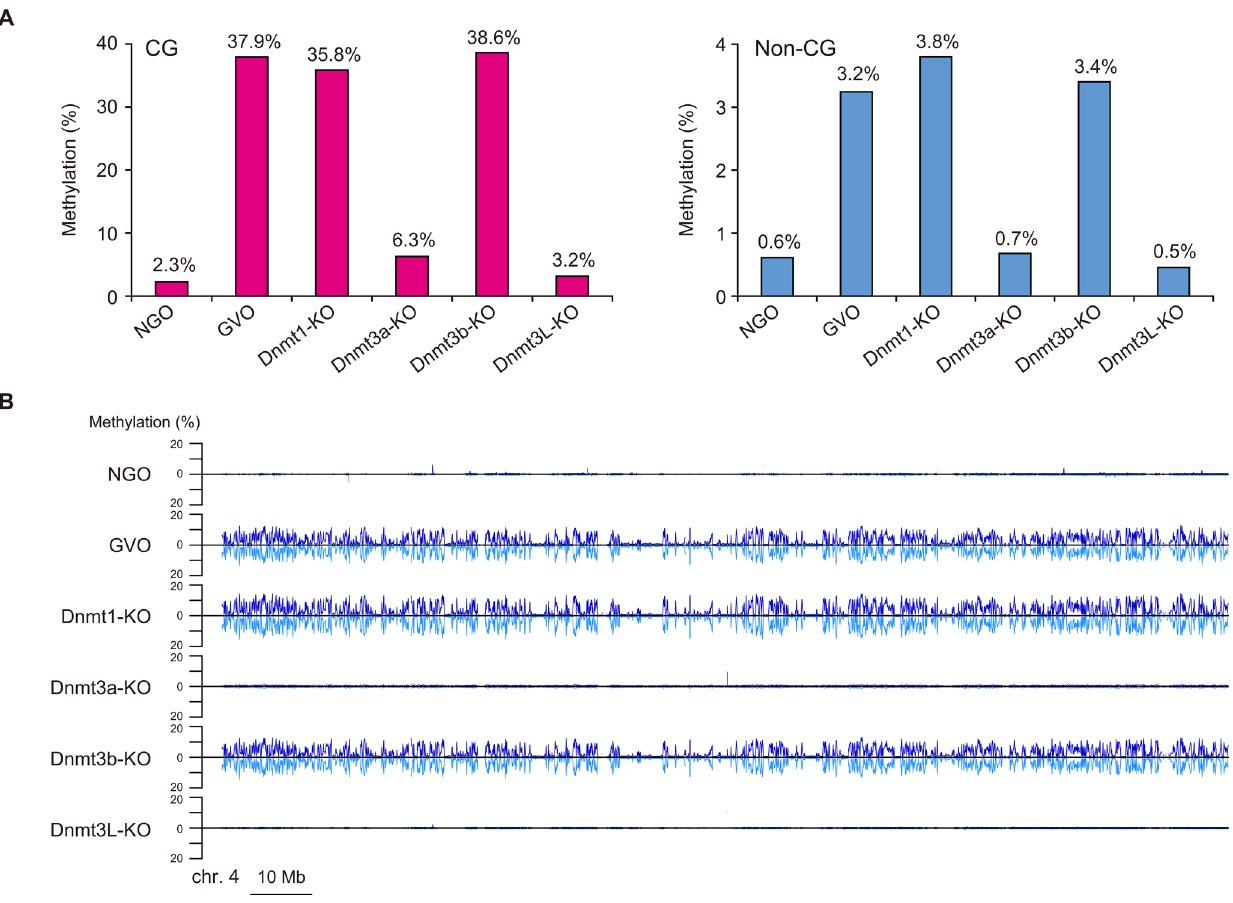
Figure 4. Comparison of the methylomes in NGOs, GVOs, and Dnmt-KO. (A) Overall levels of CG methylation and non-CG methylation in NGOs, GVOs, Dnmt1-KO, Dnmt3a-KO, Dnmt3b-KO, and Dnmt3L-KO. The data were not corrected for the bisulfite non-conversion rate (0.43–0.87, see Table 1). Thus, NGOs, Dnmt3a-KO, and Dmt3L-KO may actually have no or very little non-CG methylation. (B) Profiles of non-CG methylation along chromosome 4 determined using a non-overlapping sliding window of 50 kb in all samples. The data for the two strands are shown separately above and below the horizontal line.